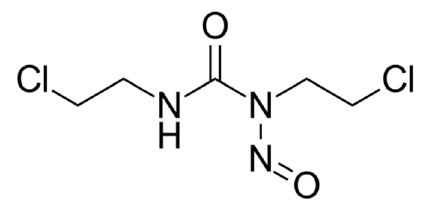
Figure 1. Carmustine (BCNU) chemical formula.